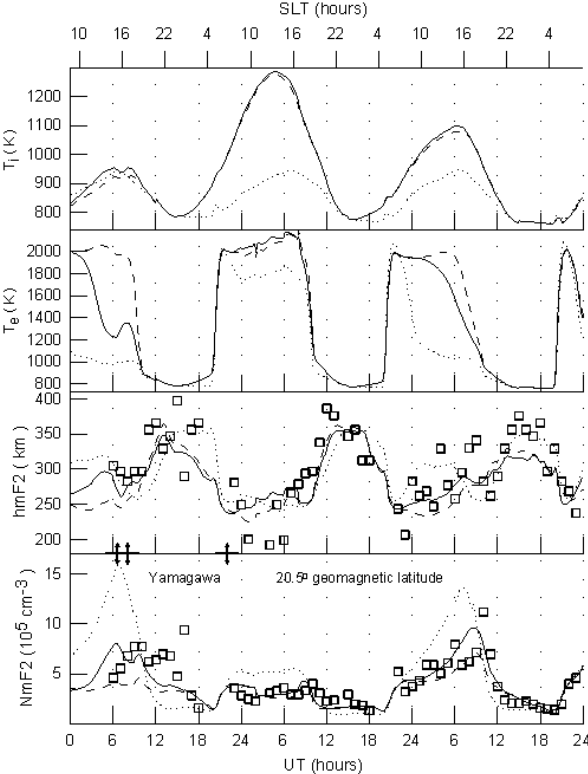
Fig. 9. From bottom to top, observed (squares) and calculated (lines) of NmF 2, hmF 2, electron temperatures and O + ion tem- peratures at the F 2-region main peak altitude above the Akita ionosonde station during 19–21 March 1988. SLT is the solar local time at the Akita ionosonde station. The start times of the sudden commencement (06:58 UT on 25 August), main phase (08:00 UT on 25 August) and recovery phase (22:00 UT on 25 August) of the geomagnetic storm are indicated by the arrows. The curves are the same as in Fig.